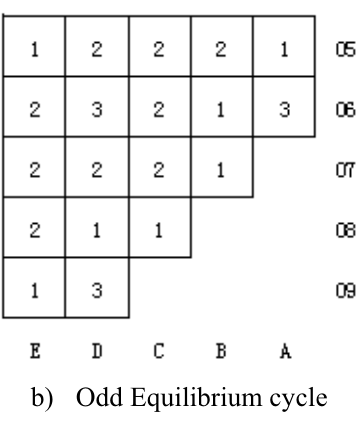
Figure 4. Loading Pattern of ACP100 (1/4